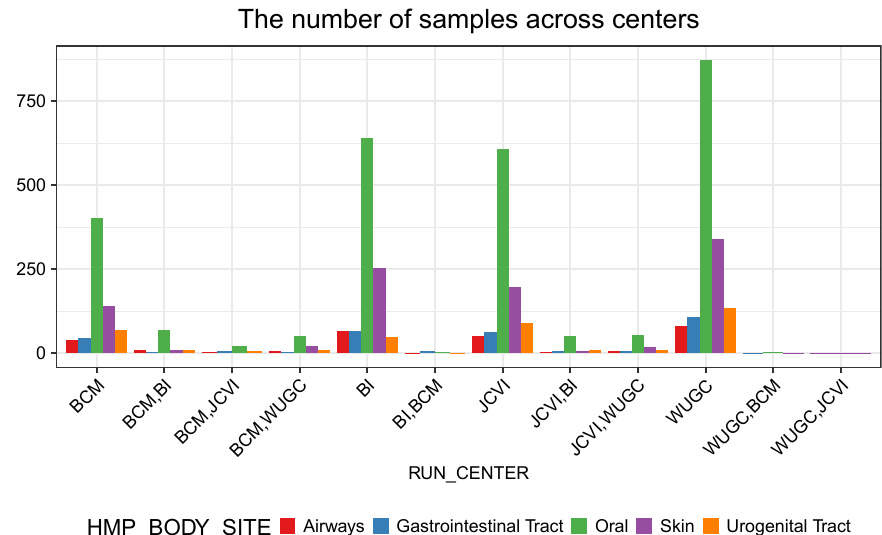
Figure 6. The number of samples from different research centers. Samples collected at different body sites are in different colors.